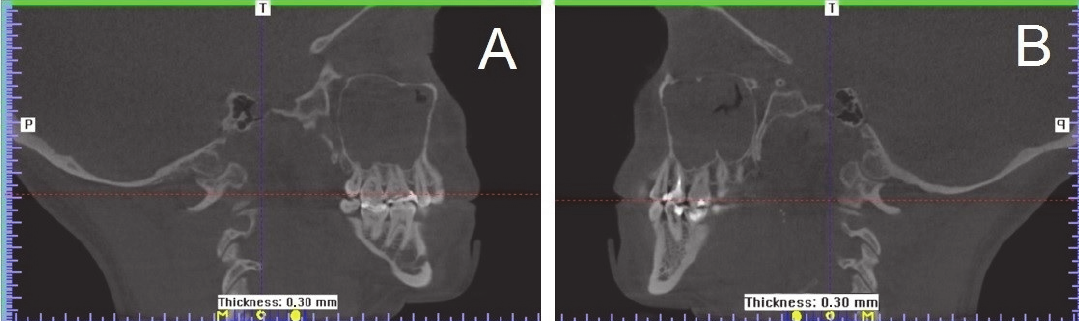
Figure 3. Maxillary sinuses in sagittal view: ( A ) Right and ( B ) left. (CBCT scans). The Viofor JPS System (Med and Life, Komorów, Poland) was used in the treatment under discussion. The system features a control unit and proprietary applicators for low